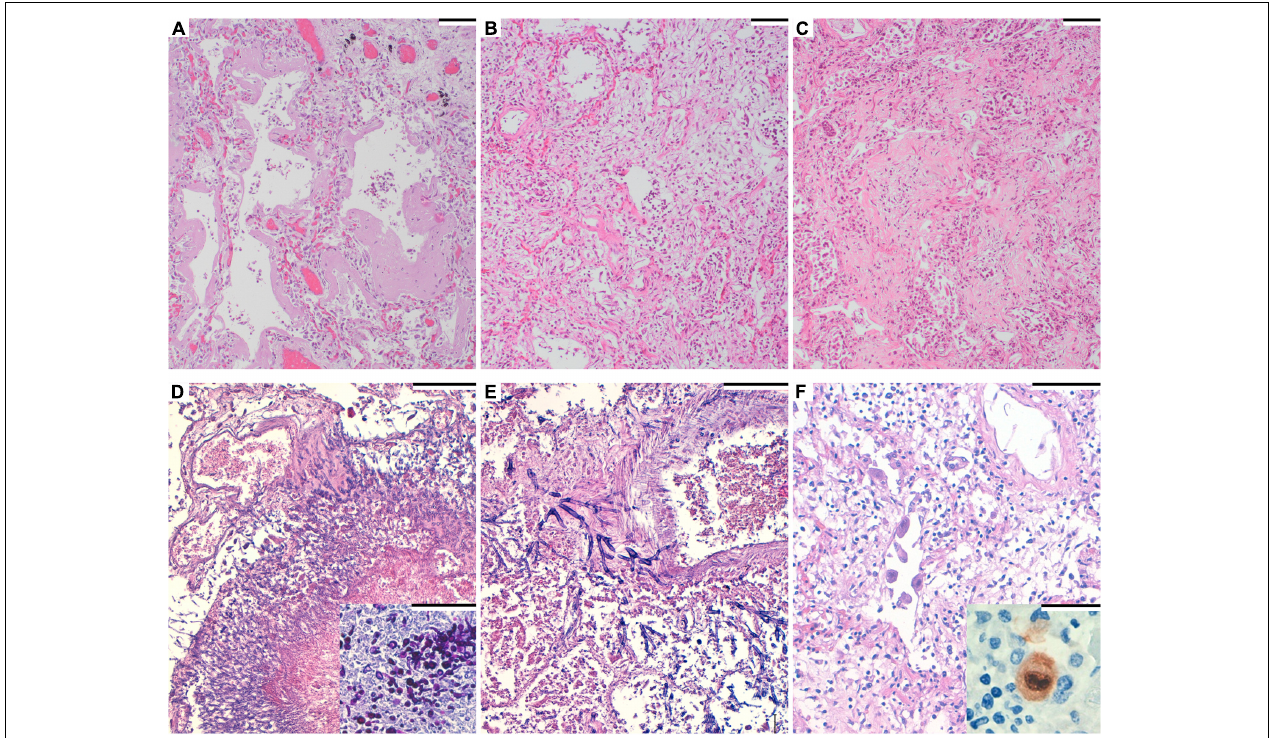
FIGURE 1 | (A) Hematoxylin and eosin. Diffuse alveolar damage (DAD), exudative phase with hyaline membranes formation. Scale bar: 100 µ m. (B) Hematoxylin and eosin. DAD, organizing phase. Scale bar: 100 µ m. (C) Hematoxylin and eosin. DAD, fibrotic phase. Scale bar: 100 µ m. (D) Hematoxylin and eosin. Numerous filamentous fungi are seen in the lung. Scale bar: 100 µ m. Inset: Periodic acid–Schiff staining, highlighting the fungi. (E) Hematoxylin and eosin. Filamentous fungi invading the arteriolar wall in angioinvasive aspergillosis. Septate hyphae with dichotomous branching at acute angles of around 45 ◦ are apparent. Scale bar: